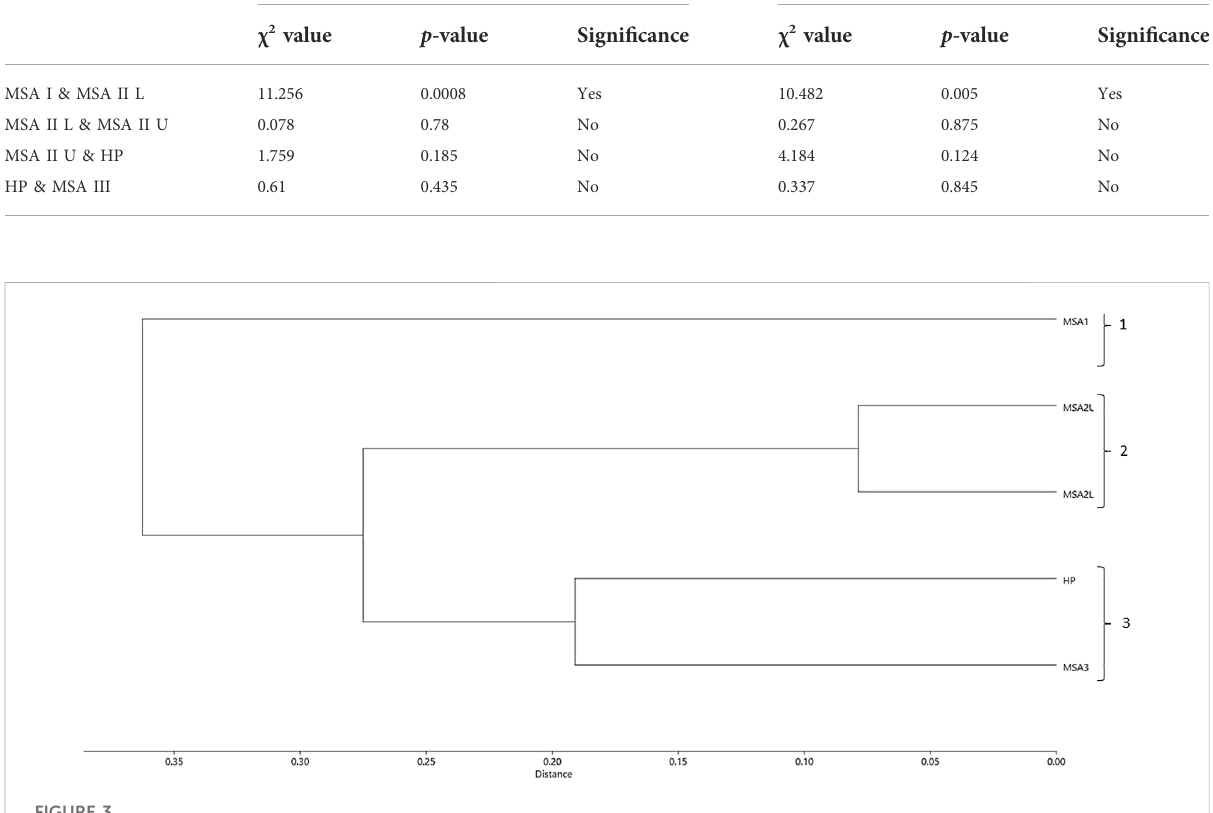
FIGURE 3 Cluster analysis of herbivore functional types based on Hempson et al. (2015) at Klasies